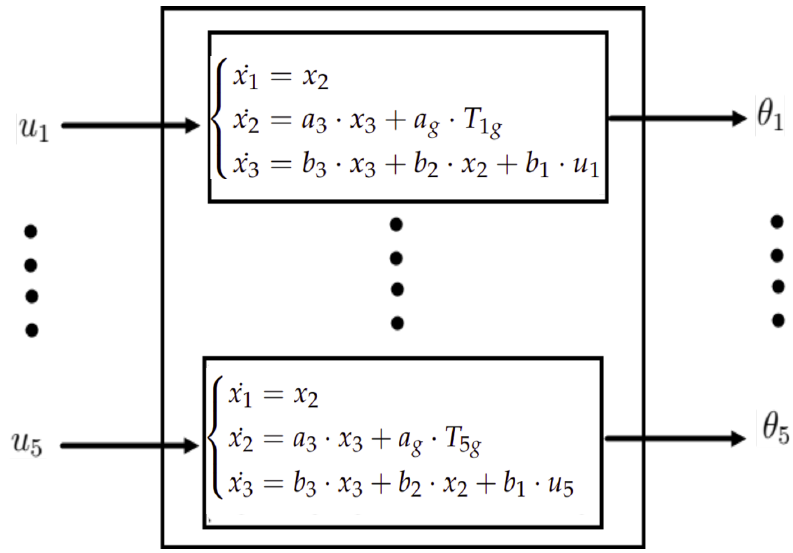
Figure 29. State model diagram.